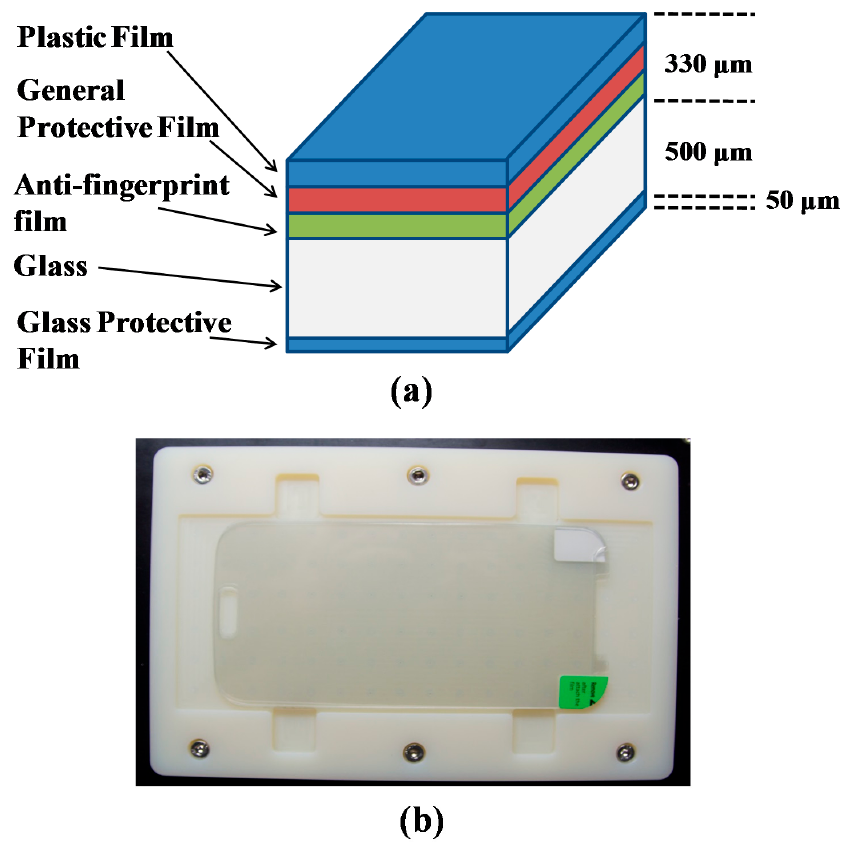
Figure 5. Optical thin film panel structure with camera image: ( a ) optical thin film panel with individual layer thickness; ( b ) optical thin film panel placed on the scanning stage.